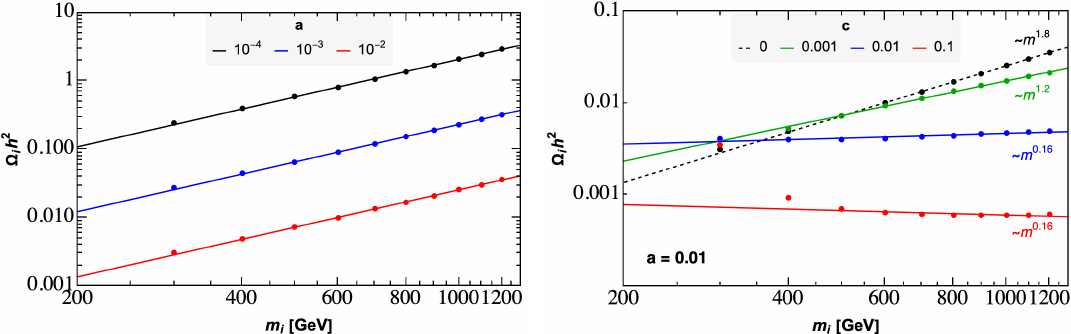
Figure 6 . Individual abundances with DM mass in the light mediator case, without ( left panel ) and with ( right panel ) conversions, for N = 10